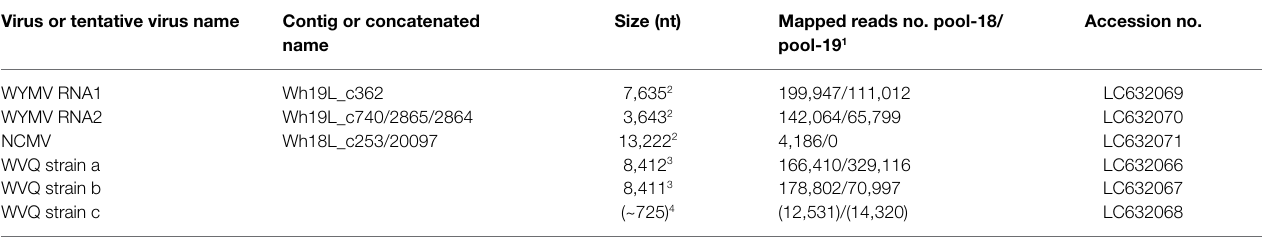
TABLE 2 | Annotated virus contigs from the wheat-leaf RNA-seq